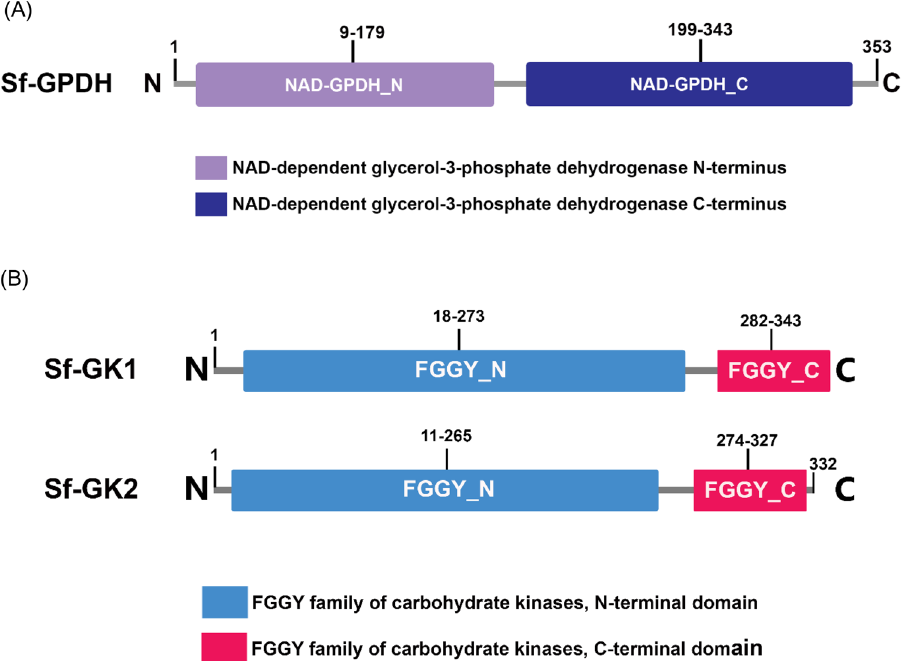
Figure 2. Protein domain analysis of glycerol biosynthesis genes of Spodoptera frugiperda . ( A ) Prediction of signature motifs of Sf-GPDH. ( B ) Prediction of signature motifs of Sf-GK1 and Sf-GK2. The functional domains were predicted using the NCBI conserved domain database and the EMBL-EBI HMMER